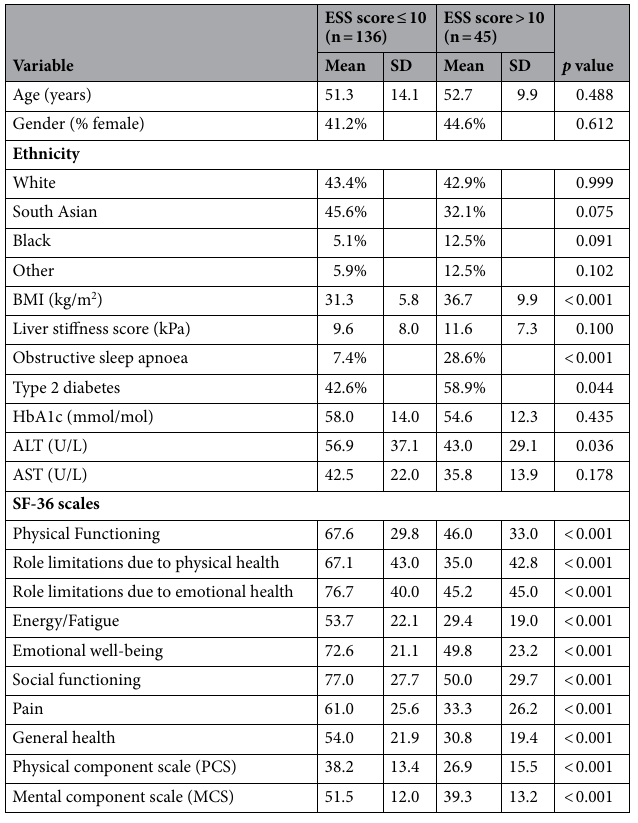
Table 2. Clinical and Quality of Life-related factors in People with NAFLD with low and high Epworth Sleepiness Scale (ESS) scores. Values are mean or %. ALT alanine aminotransferase, AST